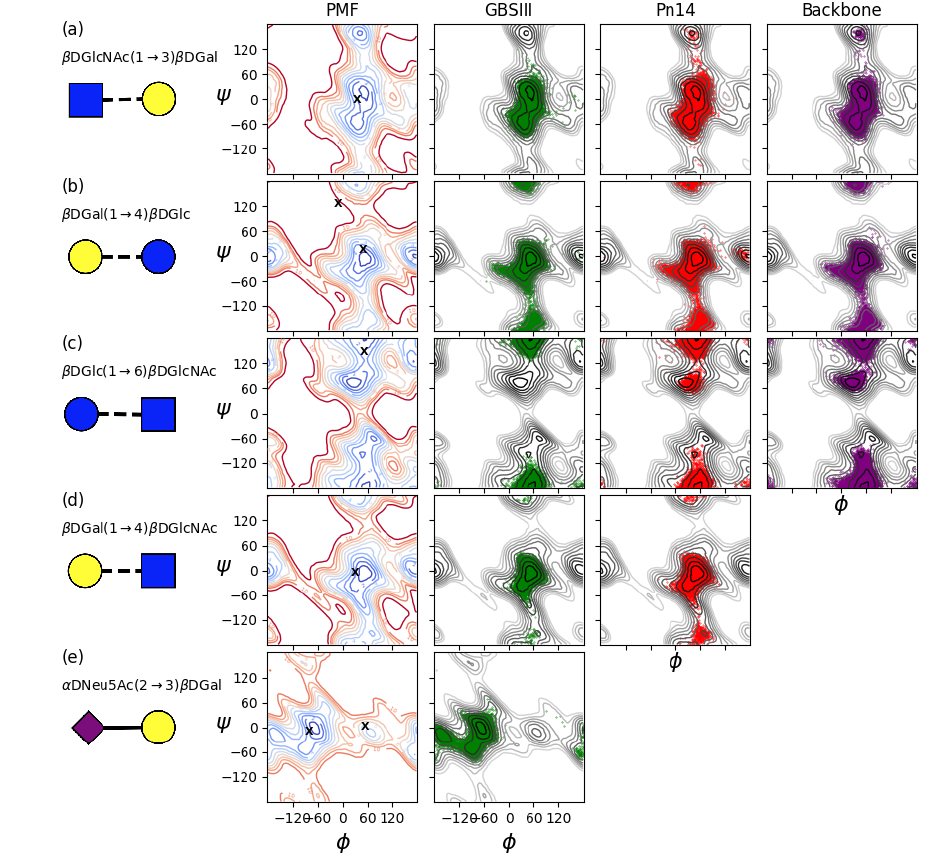
Figure A1. The left column shows contoured disaccharide φ , ψ PMF surfaces for ( a ) β D GlcNAc(1 → 3) β D Gal, ( b ) β D Gal(1 → 4) β D Glc, ( c ) β D Glc(1 → 6) β D GlcNAc, ( d ) β D Gal(1 → 4) β D GlcNAc and ( e ) α D Neu5Ac(2 → 3) β D Gal. The PMF for the charged α D Neu5Ac(2 → 3) β D Gal disaccharide is in solution, all others are gas-phase. Contours are drawn at intervals of 1 kcal · mol − 1 to a maximum of 12 kcal · mol − 1 and ‘X’ markers indicate dihedral angle values from the six-sugar GBSIII epitope in complex with Fab crystal structure [13]. Scatter plots of the corresponding two central linkages in the 6RU oligosaccharide strands for the last 900 ns of simulation time are superimposed on the PMFs for 6RU of GBSIII (column 2, green), Pn14 (column 3, red) and the unbranched backbone (right column,